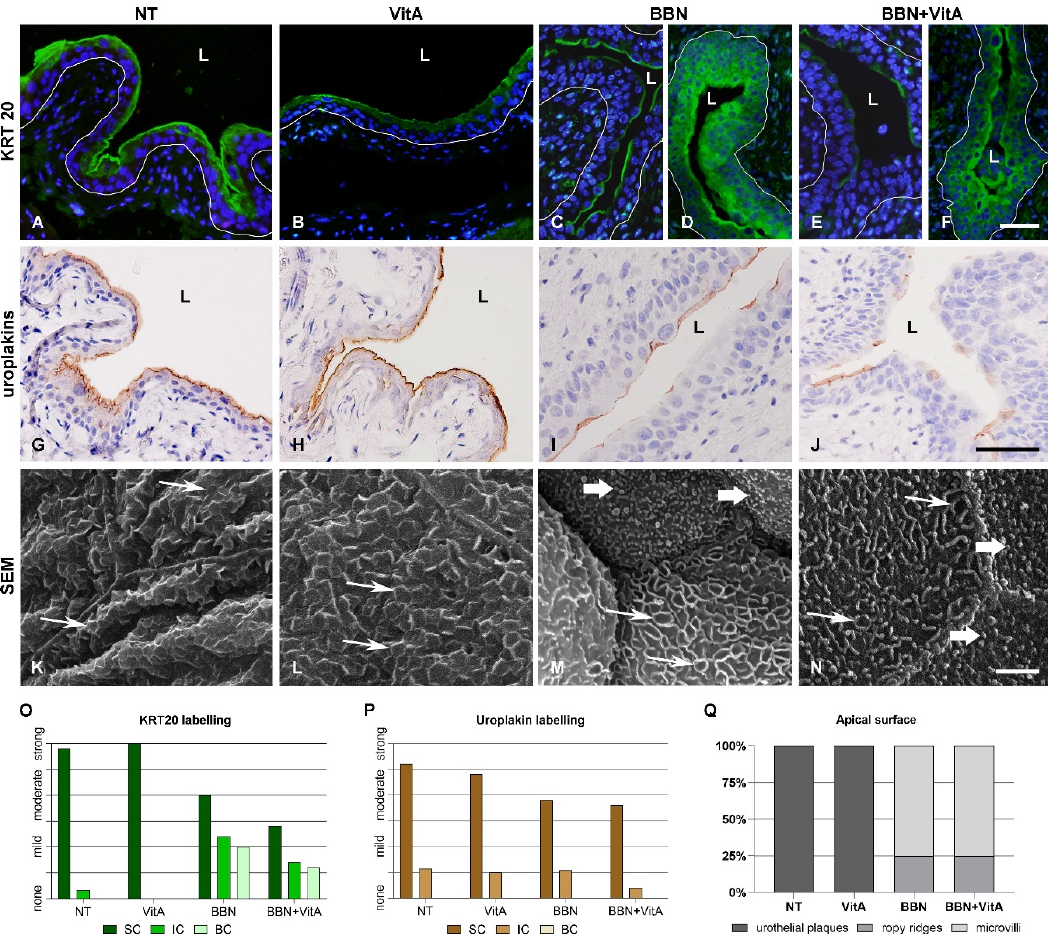
Figure 2. Differentiation markers of urothelium after BBN treatment and vitamin A rich diet. ( A – D ) Keratin 20 (KRT20) immunofluorescence. KRT20 labelling (green) is strong in the umbrella cells of NT and VitA groups. In BBN and BBN + VitA groups, two different areas are observed. ( C , E ) In some areas, the apical cytoplasm of individual superficial cells is positive and ( D , F ) in other areas,